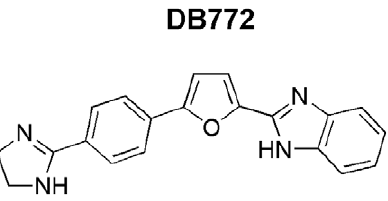
Figure 1. Structure of 2-(2-benzimidazolyl)-5-[4-(2-imidazoli- no)phenyl]furan dihydrochloride (DB772).